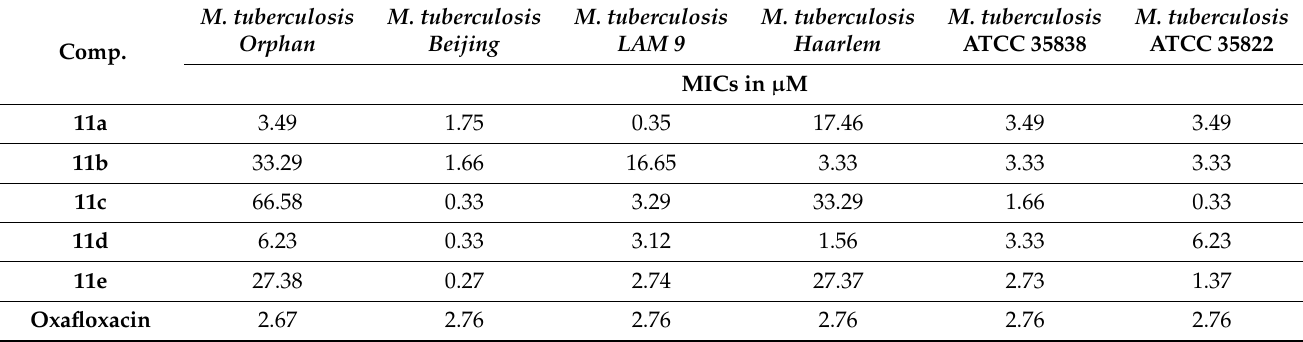
Table 9. Antimycobacterial activity against M. tuberculosis